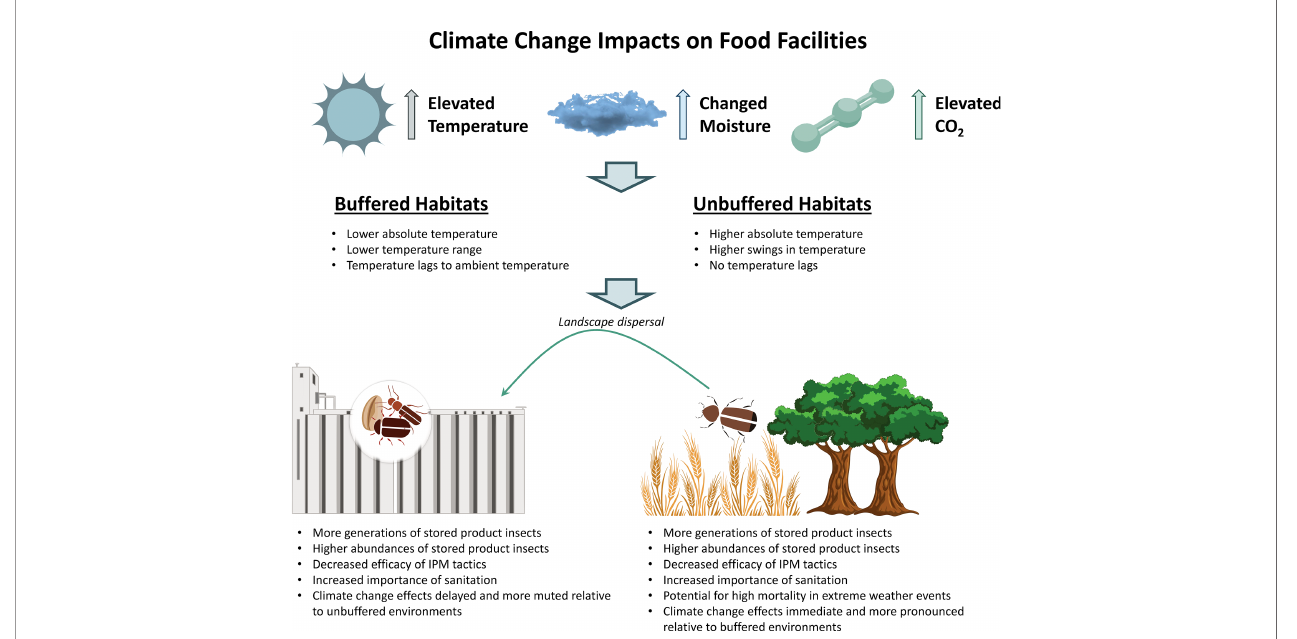
FIGURE 2 | Climate change impacts (e.g. elevated temperature, changed moisture, elevated CO2) at food facilities, including buffered and unbuffered environments, and how this affects each environment